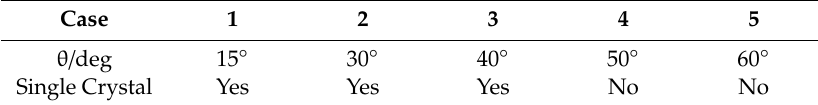
Table 3. Grain selection of Z-form grain selector with di ff erent take-o ff angles.